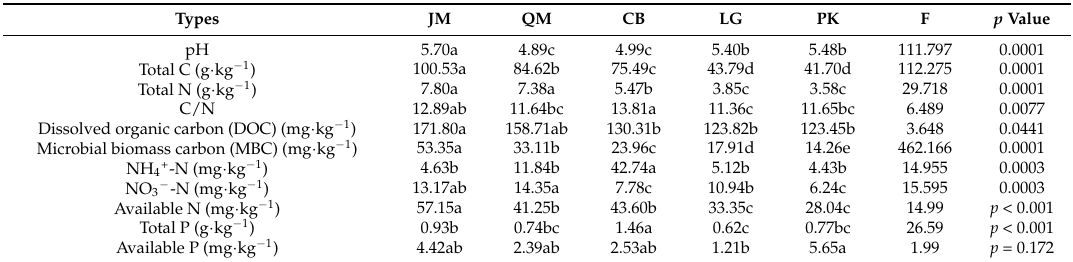
Table 1. Soil chemical characteristics of different revegetation